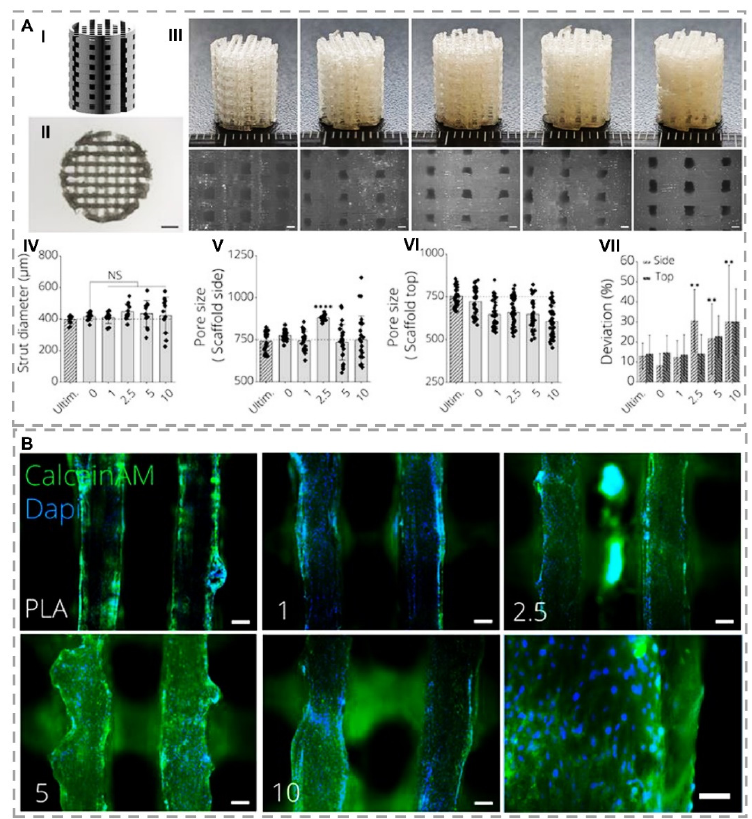
Figure 4. ( A ) Mechanical properties of 3D-printed PLA-45S5 BG scaffolds. (I) designed scaffold using CAD with pore sizes in 750 µm width. (II) Top view image of a PLA-BG scaffold using light microscopy with scale bar = 2 mm. (III) 3D-printed scaffold with FDM method with 0, 1, 2.5, 5, and 10 wt.% BG component (respectively from left to right). Bottom row displays light microscopy images with scale bars = 500 µm. (IV-VII) PLA-BG scaffolds printability and porosity assessment in comparison by Ultimaker PLA filaments as reference depicting (IV) strut diameter, (V) scaffold porosity at side, and (VI) top, as well as (VII) deviation of pore area from theoretical pore area calculated from CAD model as a measure of printing accuracy. (** p < 0.01, **** p < 0.0001 indicate a statistically significant difference of means compared to 3D-printed 0% BG-PLA by one-way ANOVA or Welch’s t -test in pairwise comparisons of scaffold side pore diameter). ( B ) Immunohistochemistry of MC3T3E1 preosteoblast cells cultured on 3D-printed PLA-BG scaffolds after 24 h. Fluorescence microscopy images display Calcein AM (green) and DAPI (blue) stained cells on PLA-BG scaffolds with BG concentration of (I) 0, (II) 1, (III) 2.5, (IV) 5, and (V) 10 wt.% with 100 µm scale bars sizes and (VI) 10 wt.% with 200 µm scale bar size (reproduced content is open access) [79].